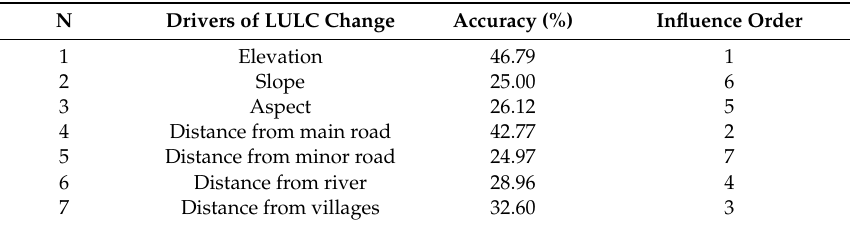
Table 5. Sensitivity analysis of drivers of LULC change.